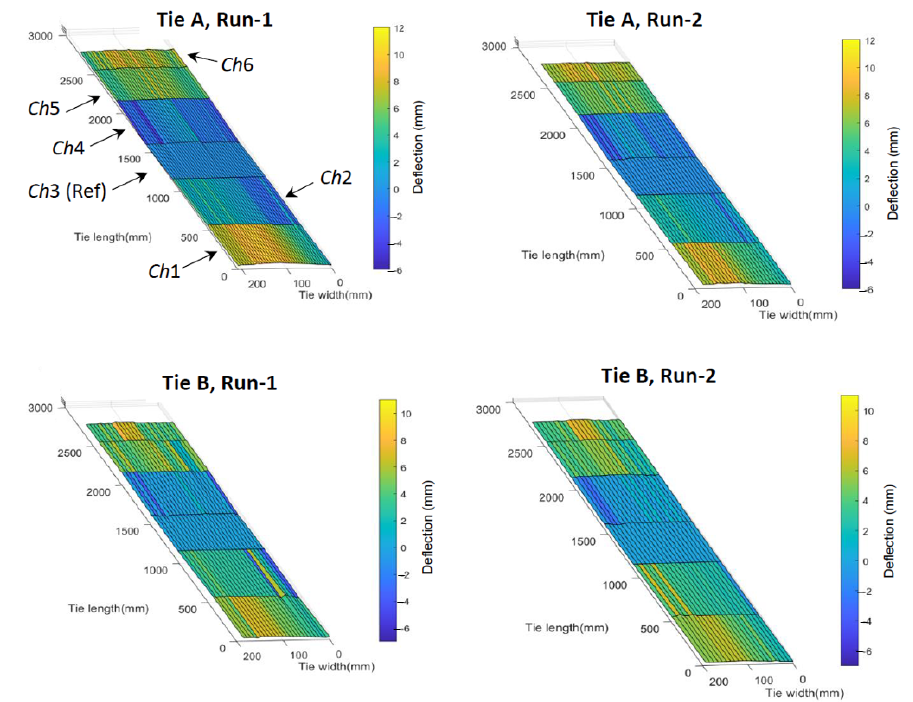
Figure 15. Full-field deflection profiles for two different ties in two independent test